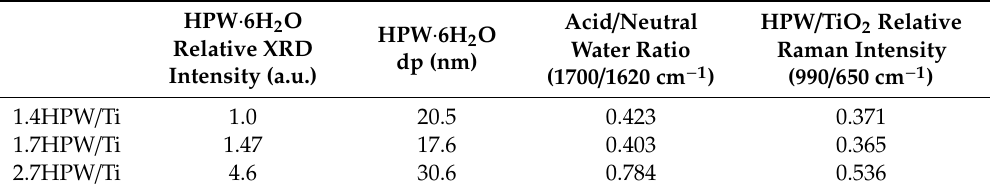
Figure 1. XRD patterns of xHPW / Ti acid catalysts: 1.4HPW / Ti (a), 1.7HPW / Ti (b) and 2.7HPW / Ti (c) (anatase ( (cid:4) ), rutile ( (cid:3) ), H 3 PW 12 O 40 6H 2 O ( • ) and H 3 PW 12 O 40 3H 2 O ( )). (cid:35) Table 1. Relative intensity and particle size of HPW · 6H 2 O (from XRD), acid / neutral water (from DRIFTS) and relative intensity of HPW (from Raman) of xHPW / Ti acid catalysts.